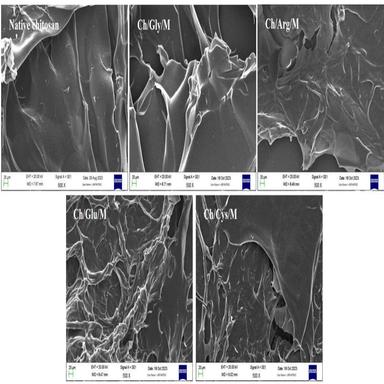
SEM images of chitosan and its derivatives.